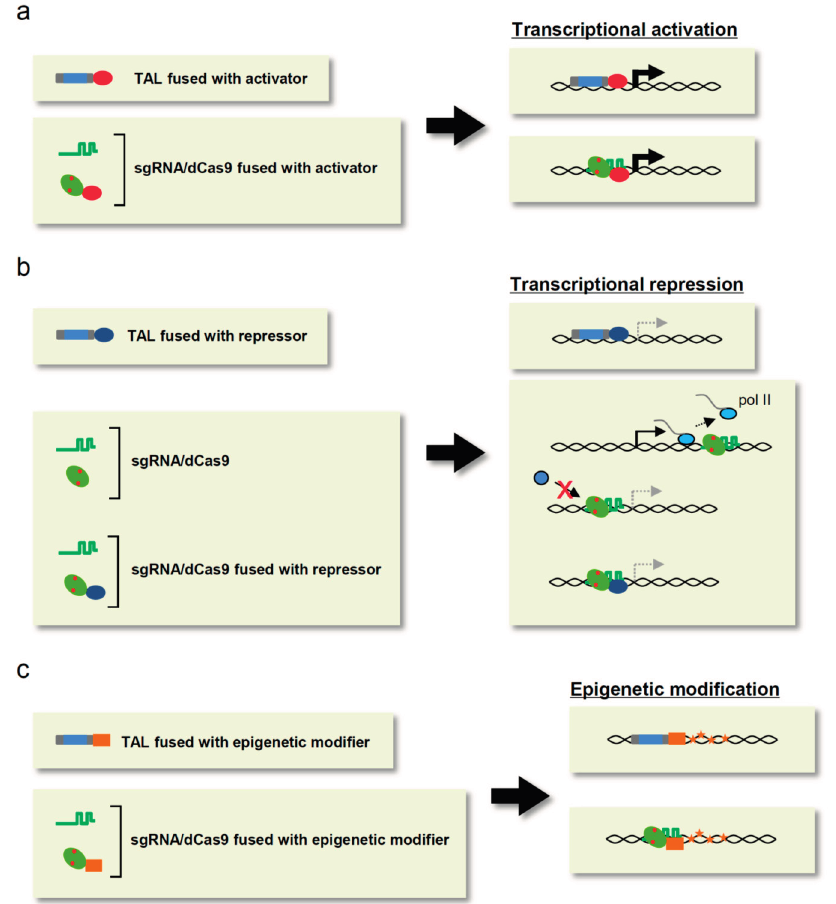
Figure 1. Applications of TAL and CRISPR/Cas to transcriptional/epigenetic regulation. ( a ) Locus-specific transcriptional activation system. Transcriptional activators fused with TAL or dCas9 increase the transcription of target genes. TAL: grey and blue rectangle. The blue rectangle is the DNA-binding domain; sgRNA: green line; dCas9: green ellipse with two red dots. The red dots indicate point mutations; transcriptional activator: red ellipse; activated transcription: thick bent arrow; ( b ) Locus-specific transcriptional repression system. Transcriptional repressors fused with TAL or dCas9 suppress the transcription of target genes. Alternatively, it is possible to block elongation of RNA polymerase II (pol II) or recruitment of transcriptional regulators to attenuate the transcription. Transcriptional repressor: blue ellipse; pol II: light blue circle; transcriptional regulator: dark blue circle; transcription: bent arrow; suppressed transcription: dashed bent arrow; ( c ) Locus-specific modification of epigenetic marks. Epigenetic modifiers fused with TAL or dCas9 alter epigenetic marks on target genes. These modifications may alter the transcriptional status of the relevant genes. Epigenetic modifier: orange rectangle; epigenetic modifications: yellow